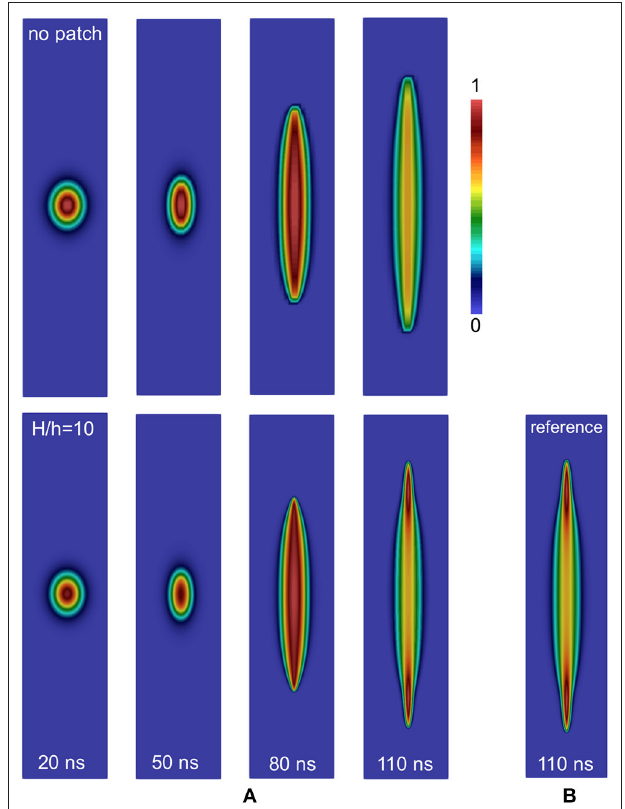
FIGURE 7 | Contour plots showing the evolution of plasma density (A) in a microwave streamer from 20 to 110 ns without (top) and with patch H / h = 10 (bottom) in the patched region. The initial plasma density is a Gaussian with maximum 10 15 m − 3 in the center of the simulation domain and standard deviation 6 × 10 − 5 m. The maximum densities at the successive times are (the color scale is normalized at each time for the upper and lower plots), respectively 1.39 × 10 17 , 1.05 × 10 21 , 3.29 × 10 21 , and 4.38 × 10 21 m − 3 . Contour plot showing the plasma density (B) at 110 ns in the reference case, without patch, having a uniform refinement of the whole computational domain, H ref = H / 10 (with H ref being the step of the uniformly spaced grid), obtained in conditions of (A) . The color scale is the same of the contour plot related to 110 ns in (A) .